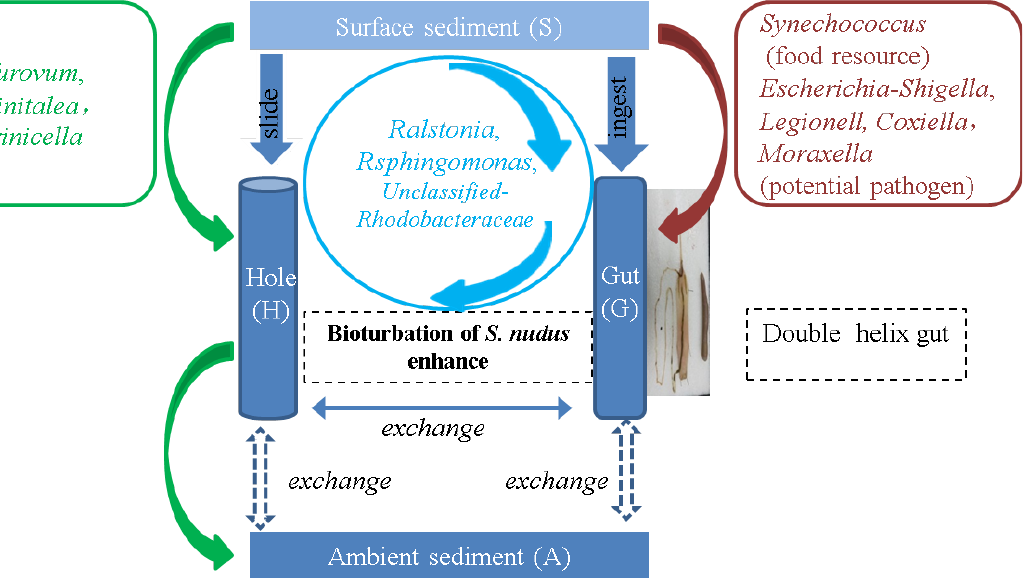
Figure 8. The interactions of microbial composition between the intestine of S. nudus and surrounding sediments. S — surface sediment; H — sediment in the hole; A — ambient sediment; G — gut of S. nudus .